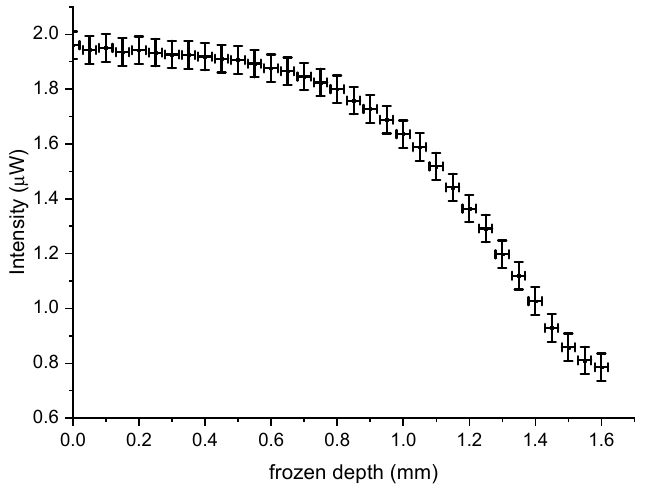
Figure 5. Calibration curve of freezing depth.